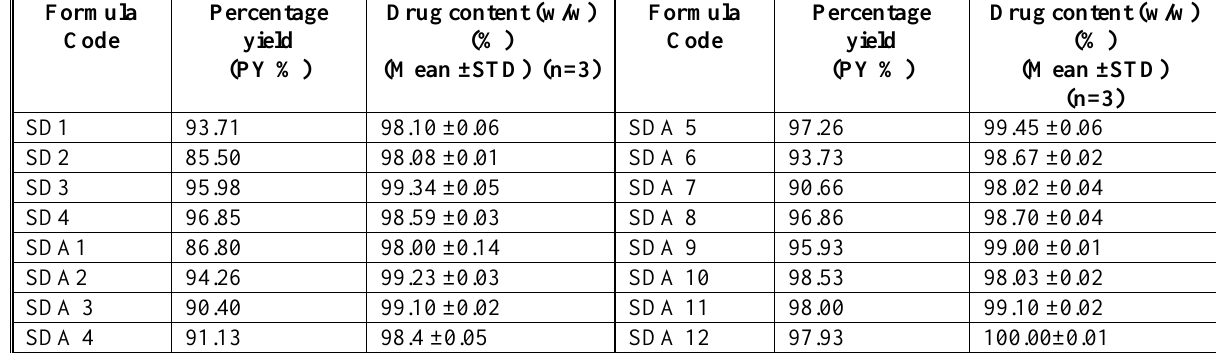
Table 5. Percentage yield and drug content of SD and SDA